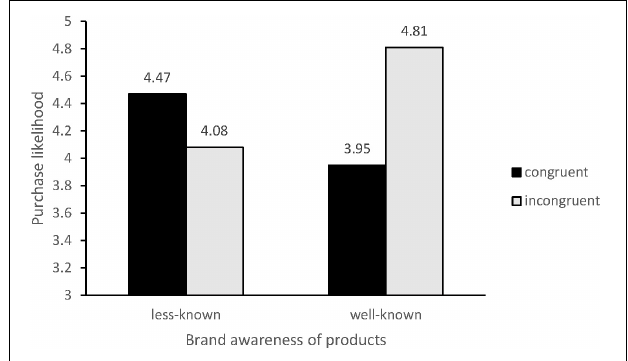
FIGURE 1 | The moderated effect of brand awareness of products.